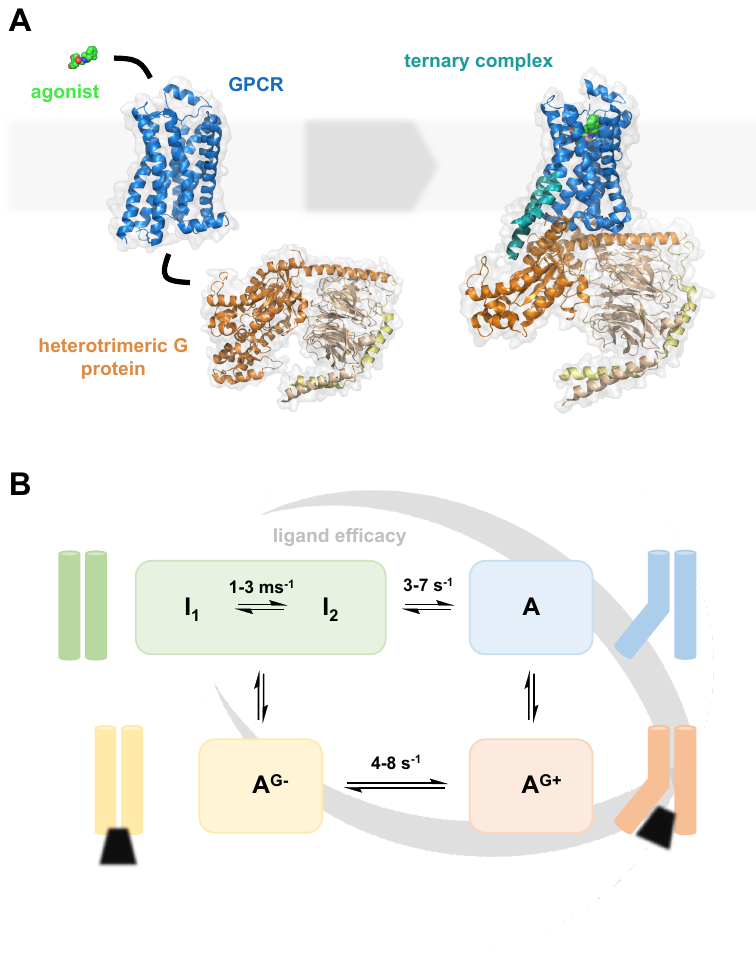
Figure 1. ( A ) Structural basis of GPCR activation. The binding of an agonist (green) induces conformational changes in the GPCR (blue), which allows the latter to interact with cytoplasmic coupling partners (CCPs), such as the heterotrimeric G protein depicted (orange / beige / yellow). In the resulting ternary complex, TM6 and TM5 (cyan) have moved out from the receptor helix bundle. This opens a cytoplasmic cavity in the receptor, which accommodates the CCP. The figure was designed with the crystal structures of the β 2 adrenergic receptor ( β 2 AR) in inactive form bound to antagonist, and in active, agonist-bound ternary state (PDB accession codes: 3NYA, 3SN6, 6EG8). ( B ) Model of the conformational equilibrium of a GPCR based on 19 F NMR studies of the β 1 adrenergic receptor ( β 1 AR)). Under physiological conditions, GPCRs adapt a complex ensemble of conformational states that are in exchange with each other. I 1 and I 2 in this model are two inactive states of the β 1 AR, that exchange at high frequencies on a ms– µ s time scale. The pre-active receptor state A is marked by an opening of the intracellular cavity of the β 1 AR. A G − reflects a pre-coupled state of the β 1 AR, in which a CCP binds to an inactive conformation of the receptor. A G + represents the fully active state of the GPCR, in which the CCP binds into the cytoplasmic cavity of the receptor that is opened by the outward movement of TM6. The binding of a ligand or CCP can shift this conformational equilibrium and can thus guide GPCR activation by conformational selection. Ligand e ffi cacy was in this context, e.g., found to correlate well with increased exchange kinetics and the population of more active states